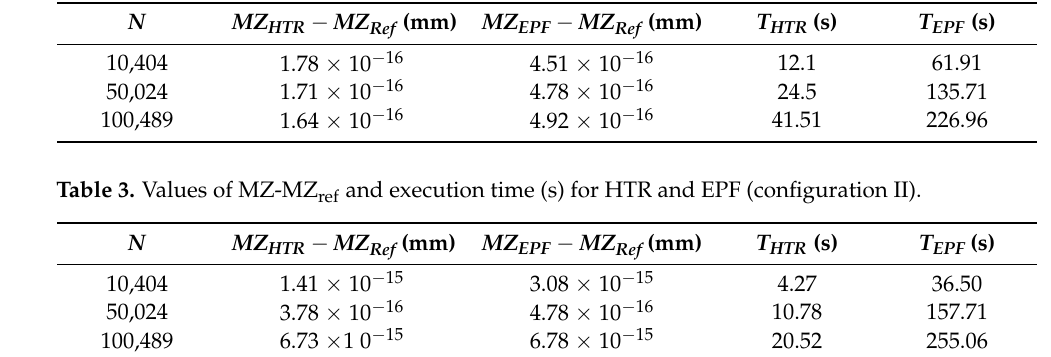
Table 2. Values of MZ-MZ ref and execution time (s) for HTR and EPF (configuration I).